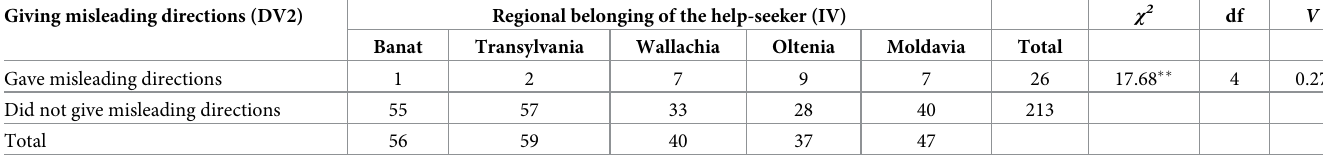
Table 2. Cross tabulation of regional belonging of help-seeker and giving misleading directions (N 1 = 239). Giving misleading directions